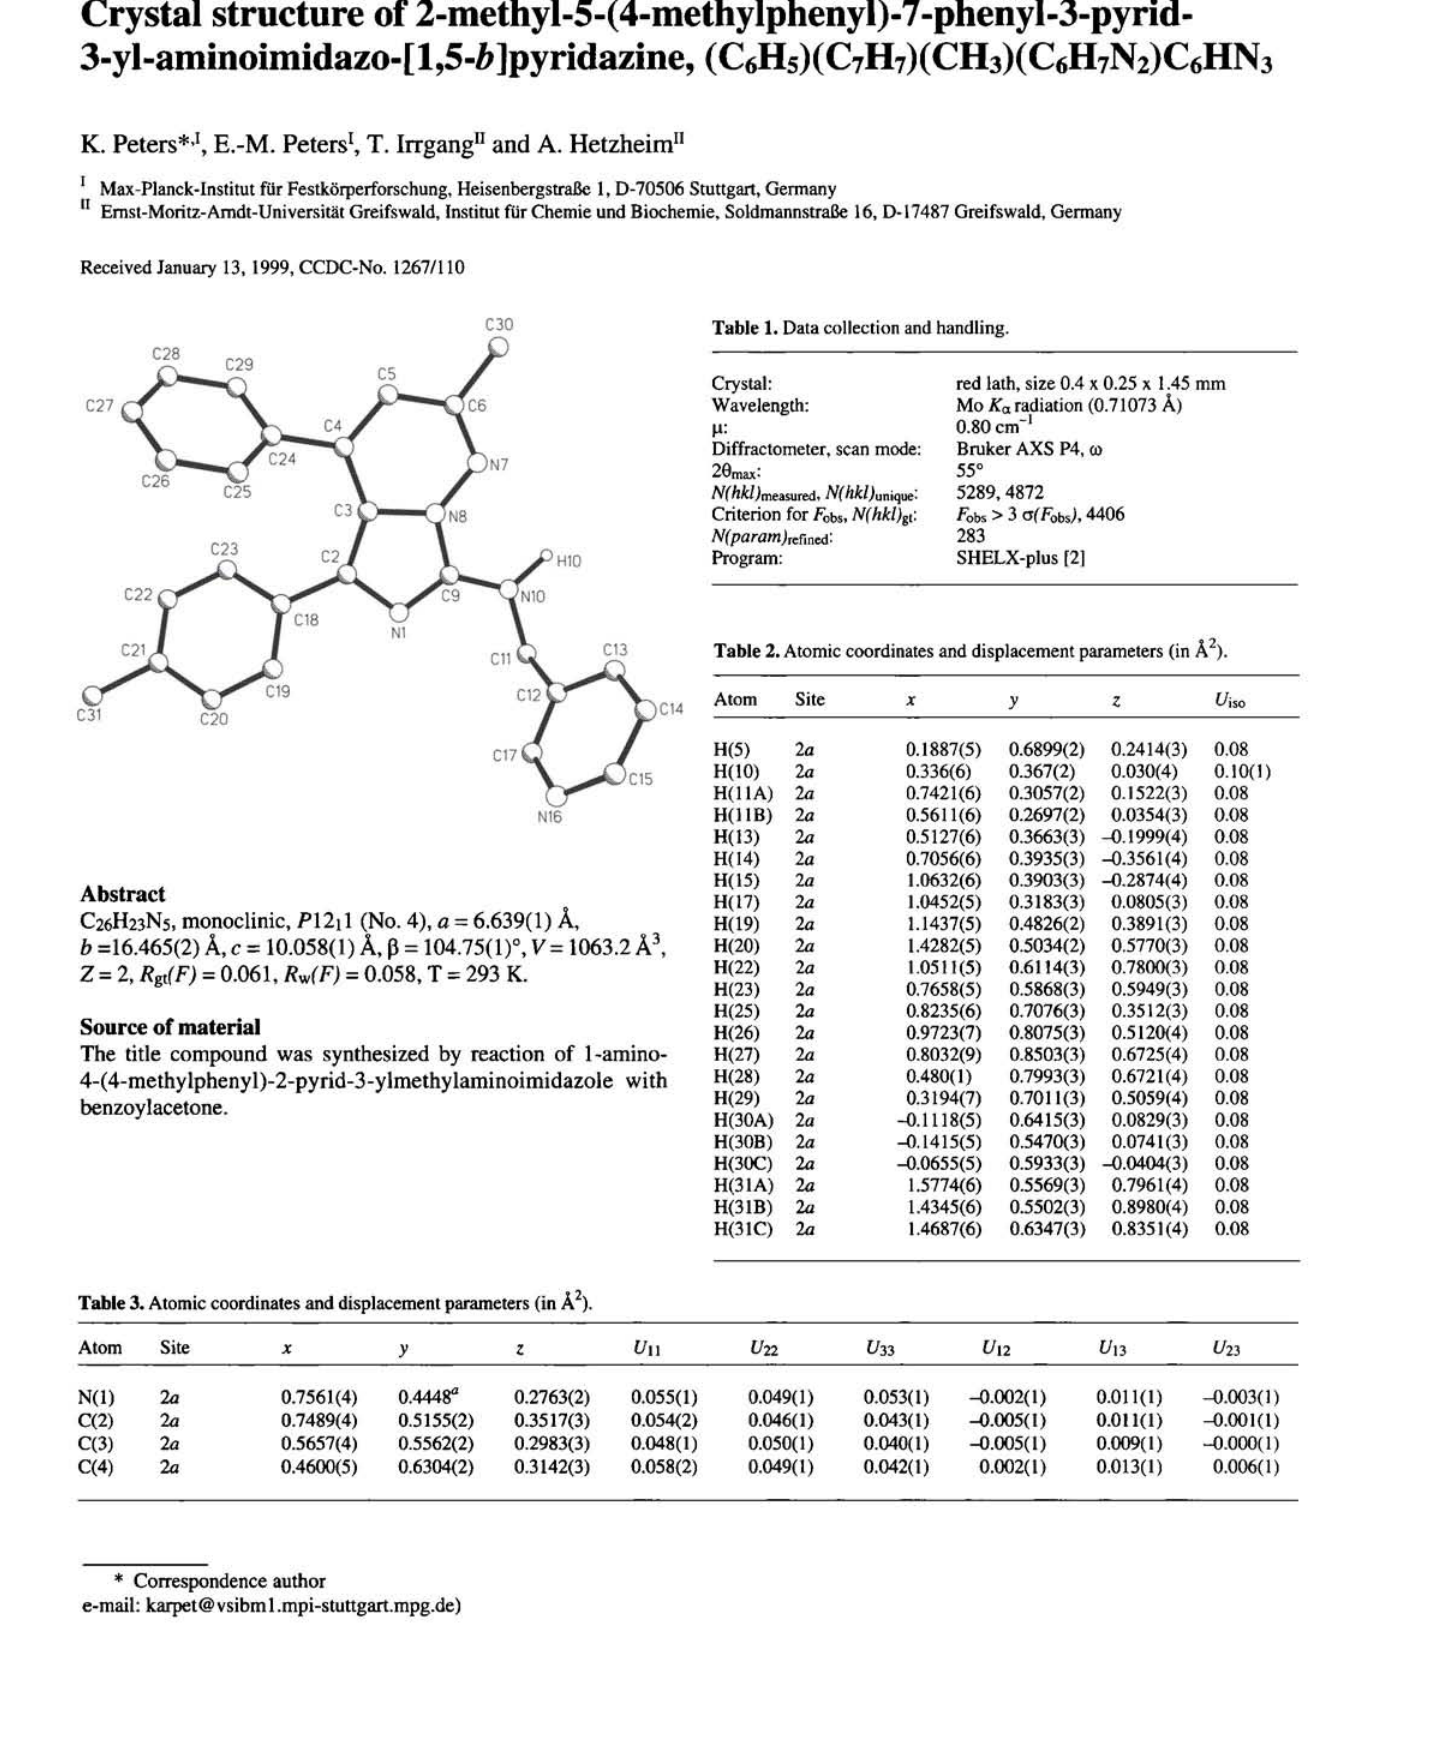
Table 3. Atomic coordinates and displacement parameters (in Â 2